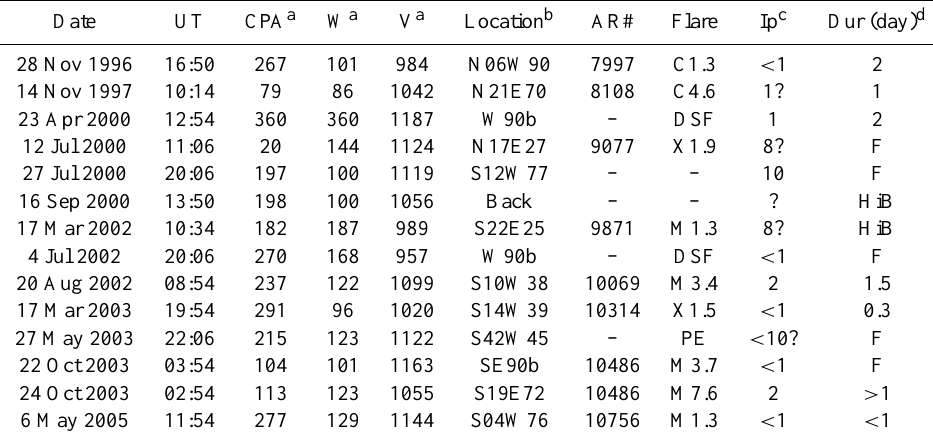
Table 2. Properties of radio-quiet fast and wide CMEs with possible SEP